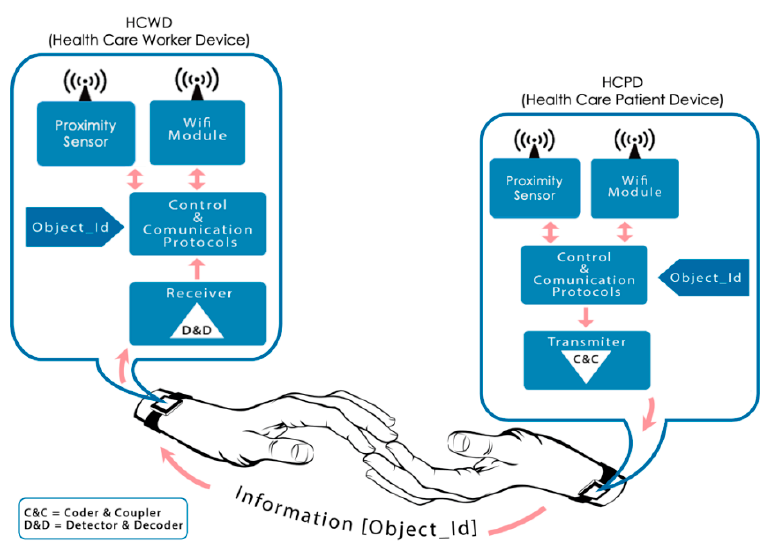
Figure 4. Touch detection